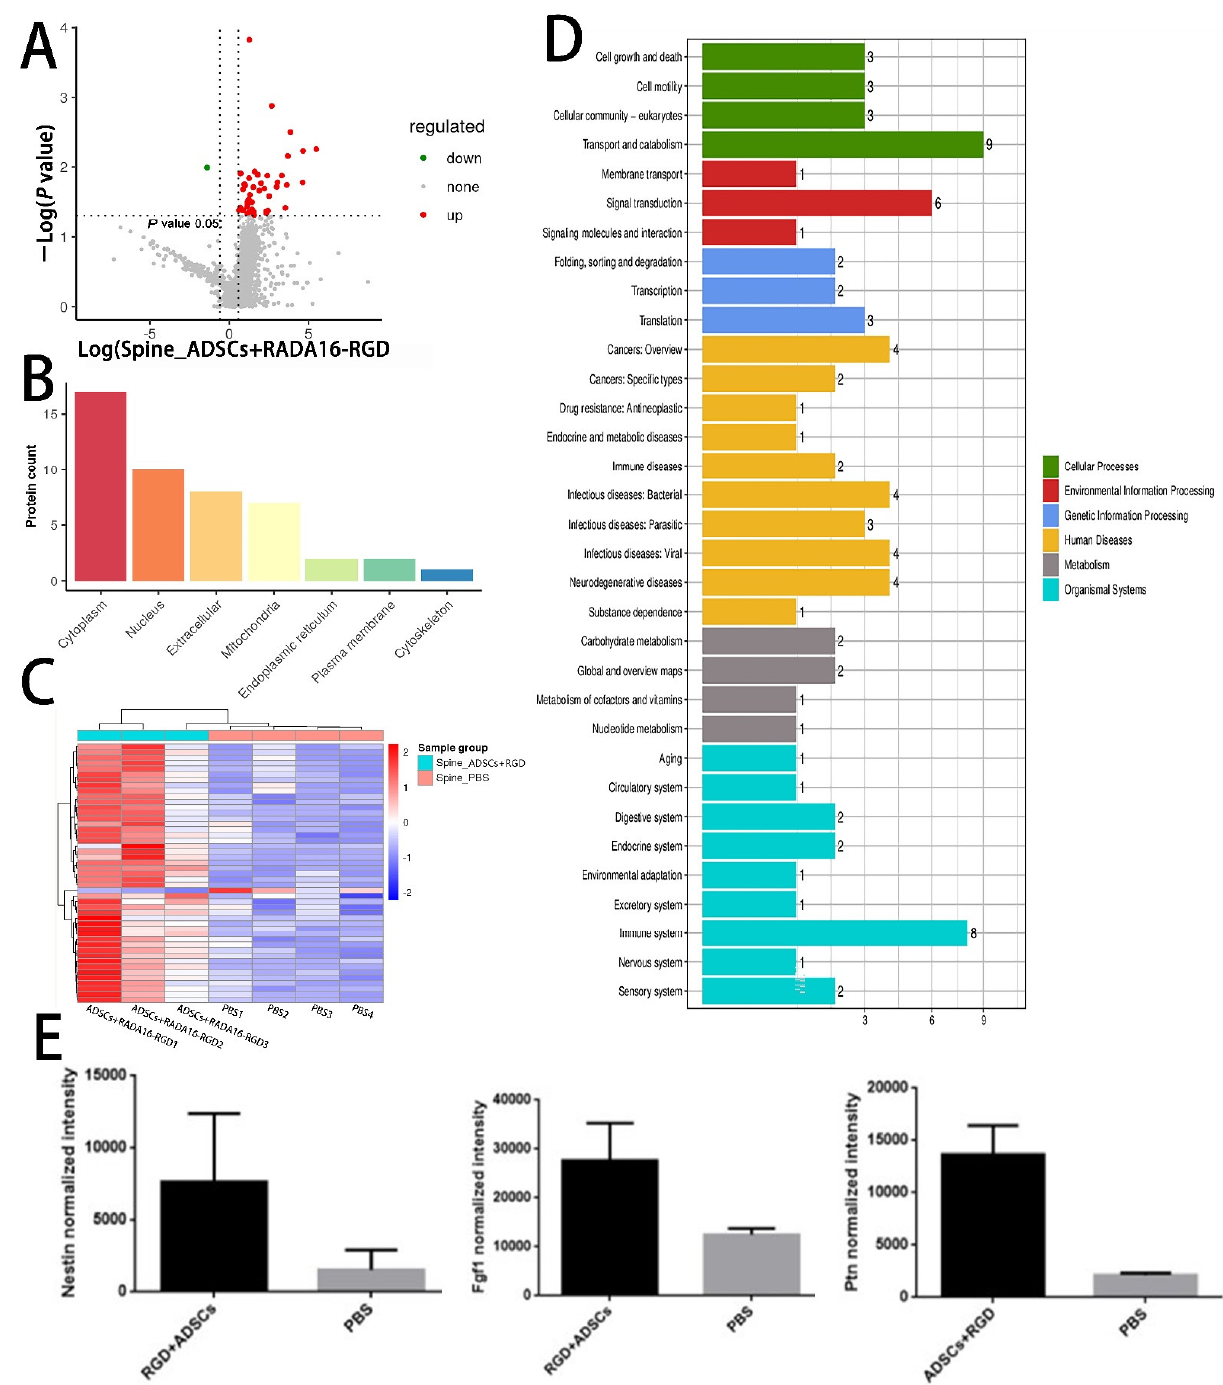
Figure 10. Differentially expressed proteins in the spinal cord of rats 2 weeks after ADSCs+RADA16- RGD transplantation. ( A ) Volcano plot of the proteins detected by liquid chromatography–mass spectrometry (LC-MS). The red dots represent the upregulated proteins and the green dots repre- sent the downregulated proteins. ( B ) The subcellular localization of the differentially expressed proteins. ( C ) Heat map showing the distribution of differentially expressed proteins. Red indicates high expression and blue indicates low expression levels. ( D ) Gene Ontology term enrichment of differentially expressed proteins. ( E ) Relative expression of nestin, FGF1, and PTN in LC-MS analysis of the ADSCs+RADA16-RGD group and PBS group.